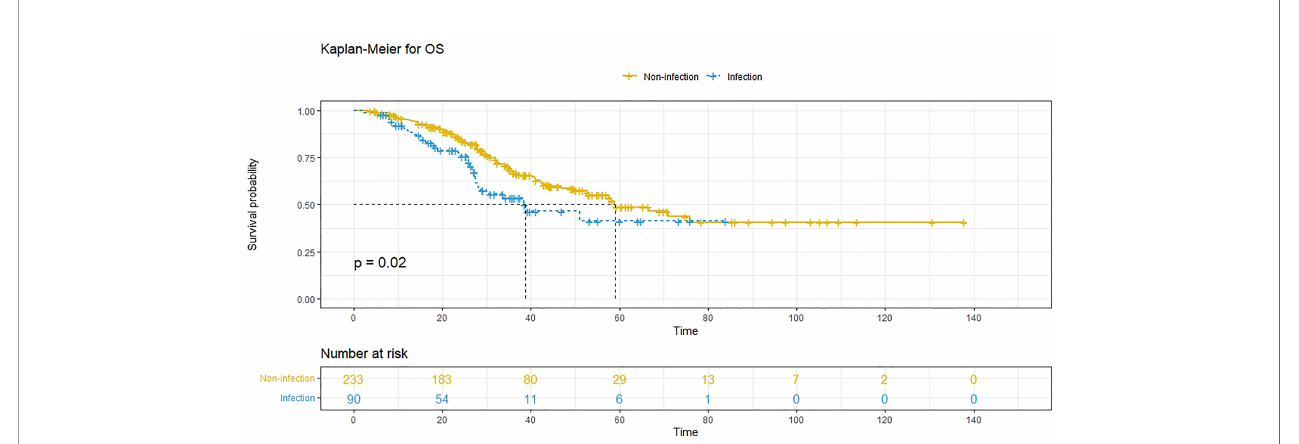
FIGURE 4 | Overall survival (OS) comparison after propensity score matching in patients with postoperative infectious complications (blue line) and patients without postoperative complications (yellow line). Infection, with postoperative infective complication. Non-infection, without postoperative infective complication.